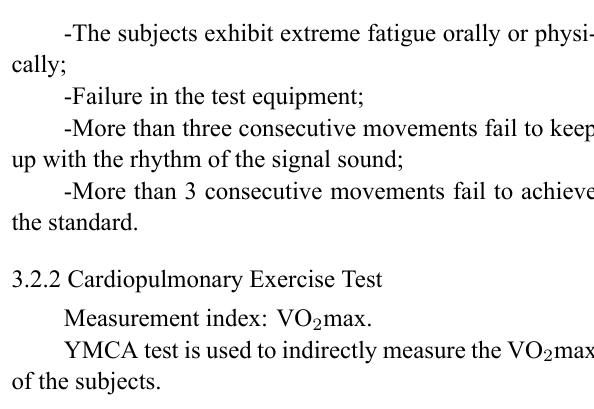
Fig. 6. Effective